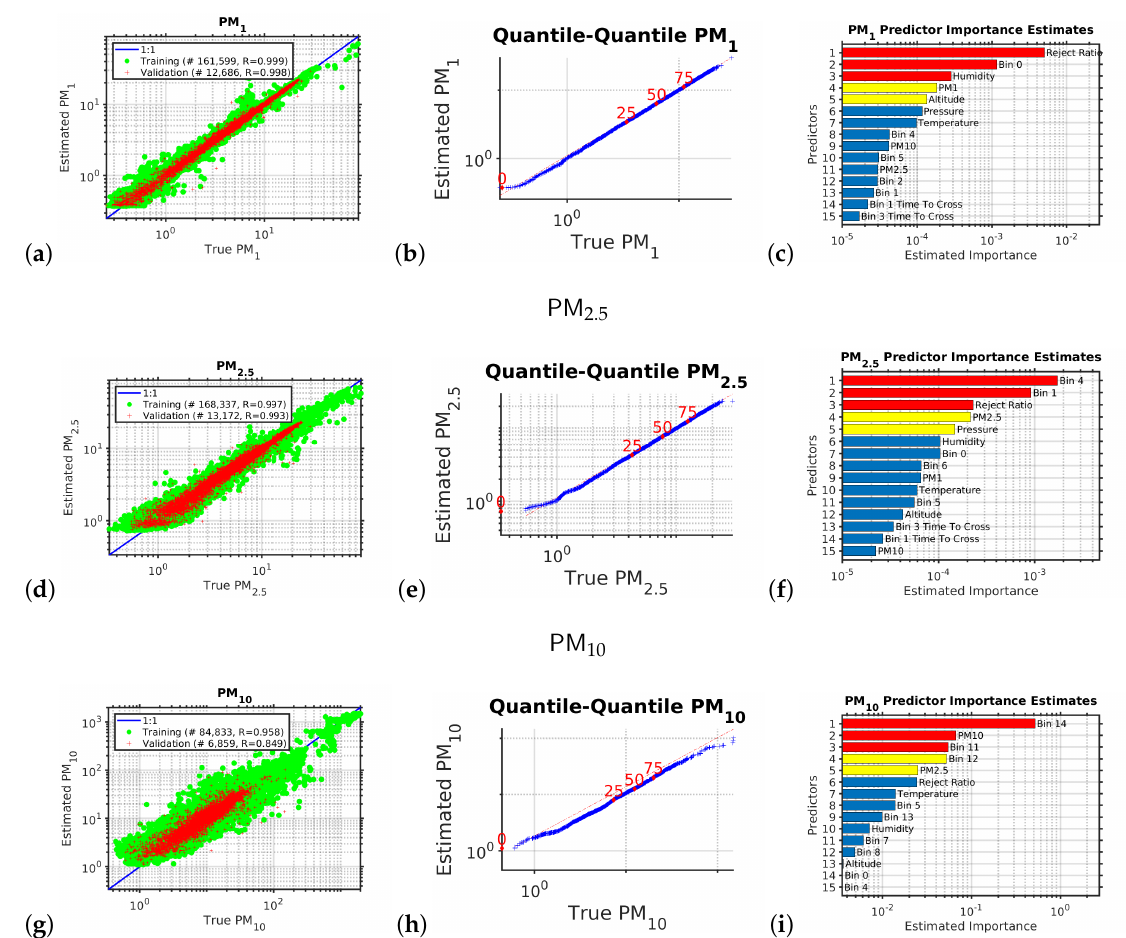
Figure 1. This figure shows the results of the multivariate non-linear non-parametric machine learning regression for particulate matter PM 1 (panels ( a )–( c )), PM 2.5 (panels ( d )–( f )), and PM 10 (panels ( g )–( i )). The left hand column of plots shows the log–log axis scatter diagrams with the x-axis showing the PM abundance from the expensive reference instrument and the y-axis showing the PM abundance provided by calibrating the low-cost instrument using machine learning. The green circles are the training data; the red pluses are the independent validation dataset. The blue line shows the ideal response. The middle column of plots shows the quantile–quantile plots for the machine learning validation data, with the x-axis showing the percentiles from the probability distribution function of the PM abundance from the expensive reference instrument and the y-axis showing the percentiles from the probability distribution function of the estimated PM abundance provided by calibrating the low-cost instrument using machine learning. The dotted red line shows the ideal response. The right hand column of plots shows the relative importance of the input variables for calibrating the low-cost optical particle counters using machine